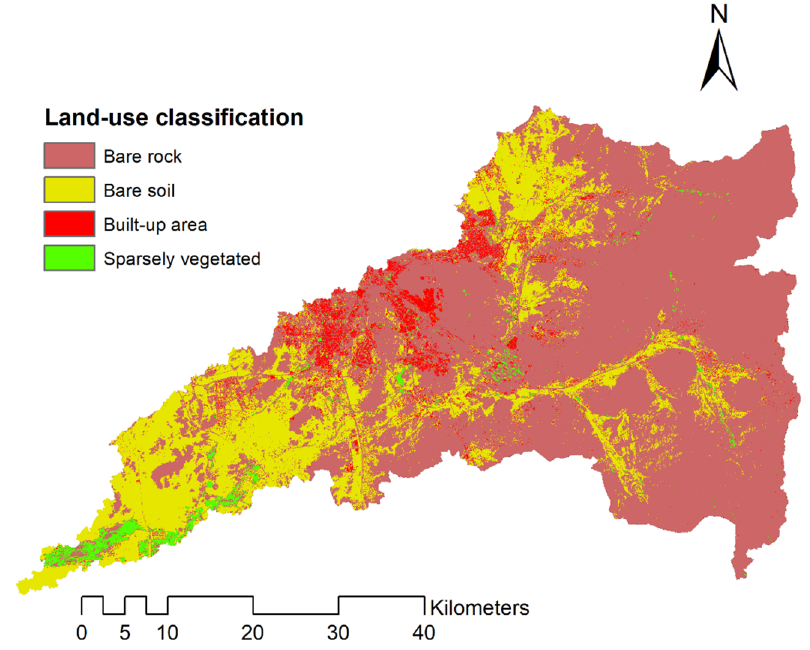
Figure 8. Land use / land cover (LULC) map of the study Figure 8. Land use/land cover (LULC) map of the study area.